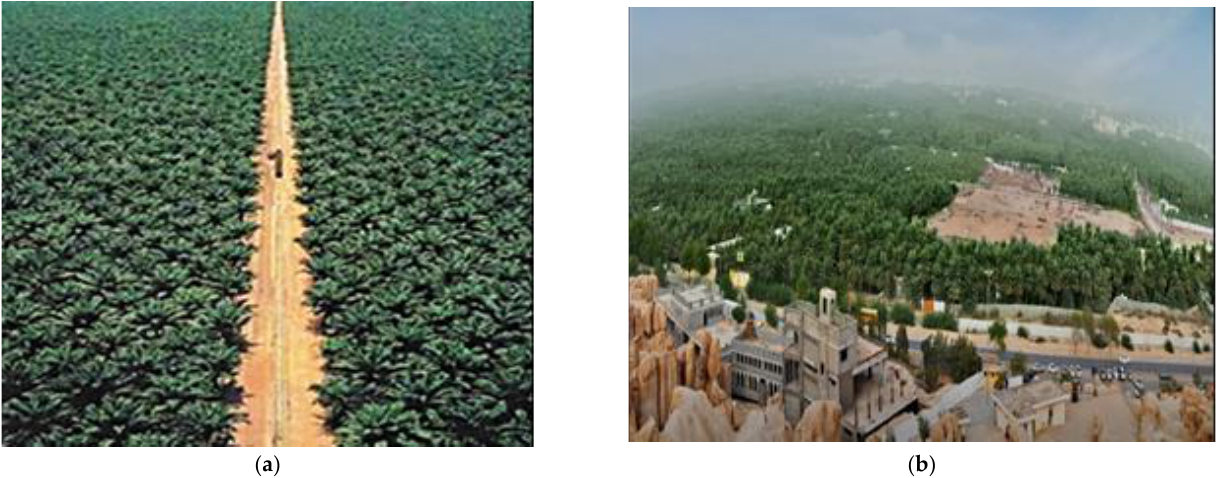
Figure 2. The largest palm tree farm and self-contained oasis in the world. ( a ) Date palm farm in Qassim, KSA; ( b ) largest self-contained oasis in the world.